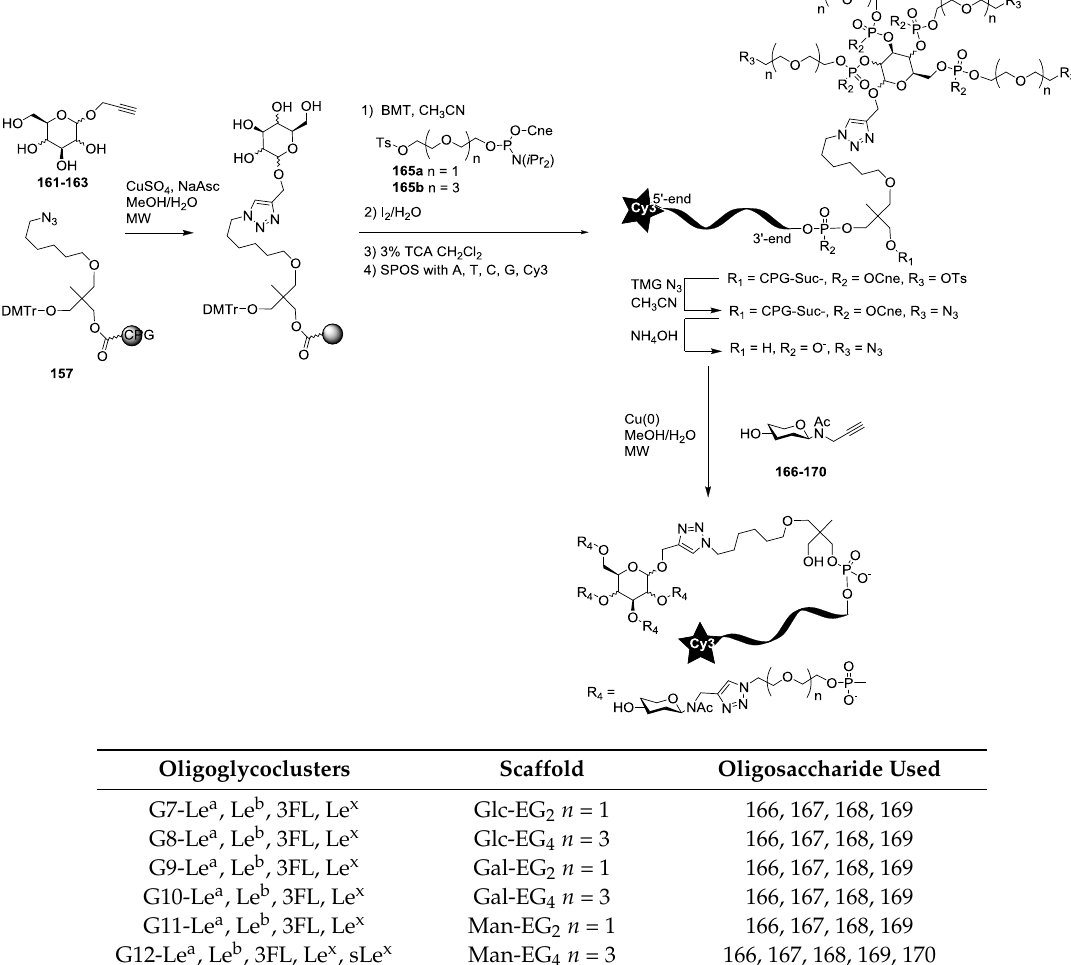
Scheme 4. Synthesis of pyranoside-centered oligosaccharide cluster oligonucleotide conjugates ( G7 to G12 series). SPOS Solid-phase oligonucleotide synthesis, Cne: Cyanoethyl, grey ball represents CPG: Controlled pore glass.